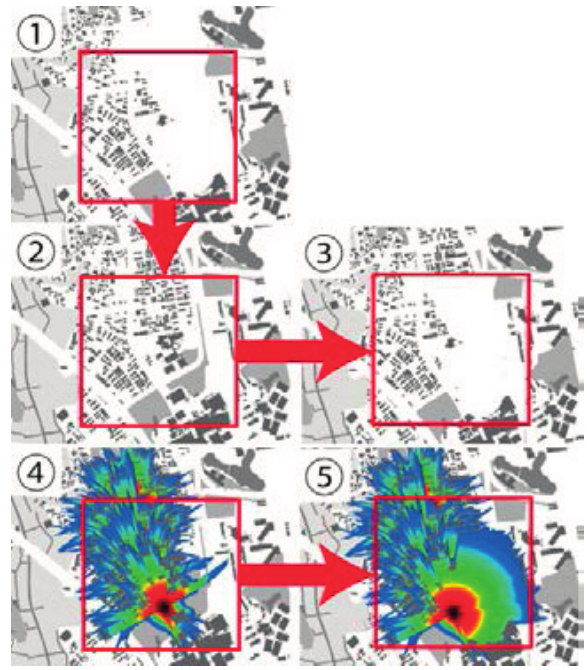
Figure 12. Experimental results of sending and receiving geographical data